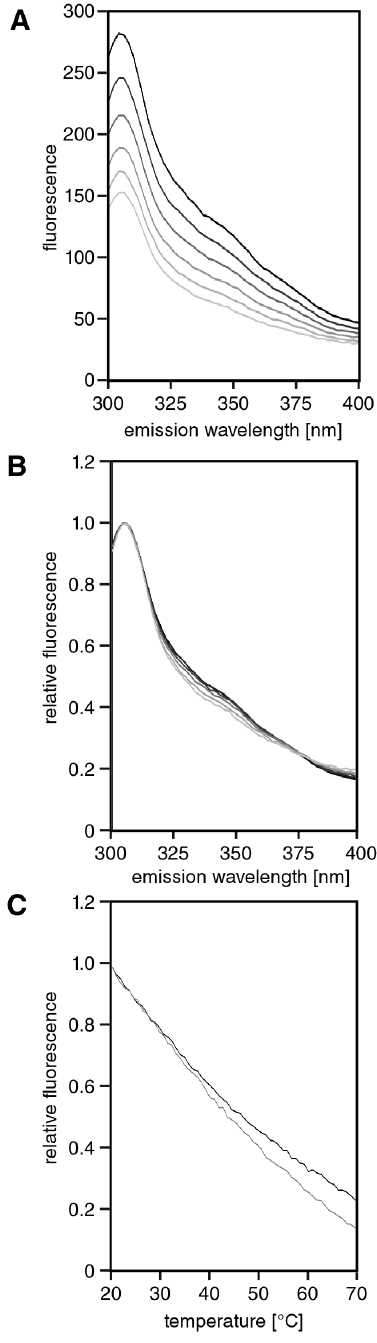
Figure 4. APC-MCR lacks a cooperative unfolding transition. A , Intrinsic protein fluorescence spectra of APC- MCR measured in 1°C steps from 20°C to 70°C, indicated by a greyscale gradient from black to light grey . B , Comparison of intrinsic tyrosine fluorescence spectra normalised to the maxima. Experiment and colour code as in A. C Temperature dependence of intrinsic tyrosine fluorescence emission of MCR upon stepwise increase of temperature at 340 nm (black) and 304 nm (grey) normalised on maxima of emission. doi: